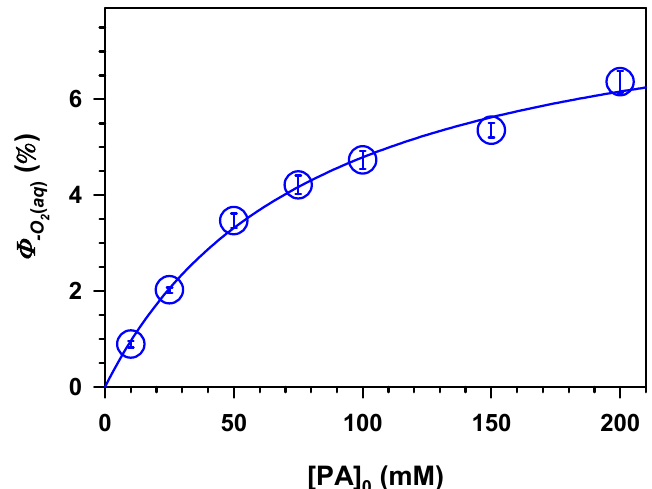
Figure 5. Quantum yield percentage of dissolved O 2 loss ( Φ − O of PA solutions at pH 1.0 and 25 ◦ C with continuous air sparging at 30.0 mL min − 1 . The absorbed photon rates are provided in Figure